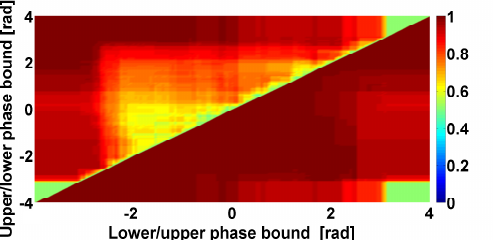
Figure 8. Example of Phase CWS AUC diagram. Tremor signals in antagonist muscles of left arm with hyperkinetic movements in PD and ET patients are analyzed. Cross-wave trains in the frequency range from 4 to 6 Hz are considered. In the upper triangular region: the abscissa axis indicates the lower bound of the phase range; the ordinate axis indicates the upper bound of the phase range. In the lower triangular region: the abscissa axis indicates the upper bound of the excluded phase range; the ordinate axis indicates the lower bound of the excluded phase range. The green rectangle in the lower left corner of the diagram is a construction artifact; it arose because the diagram axes were out of range from − π to + π . The same construction artifacts are the green triangles in the lower left and upper right corners of the